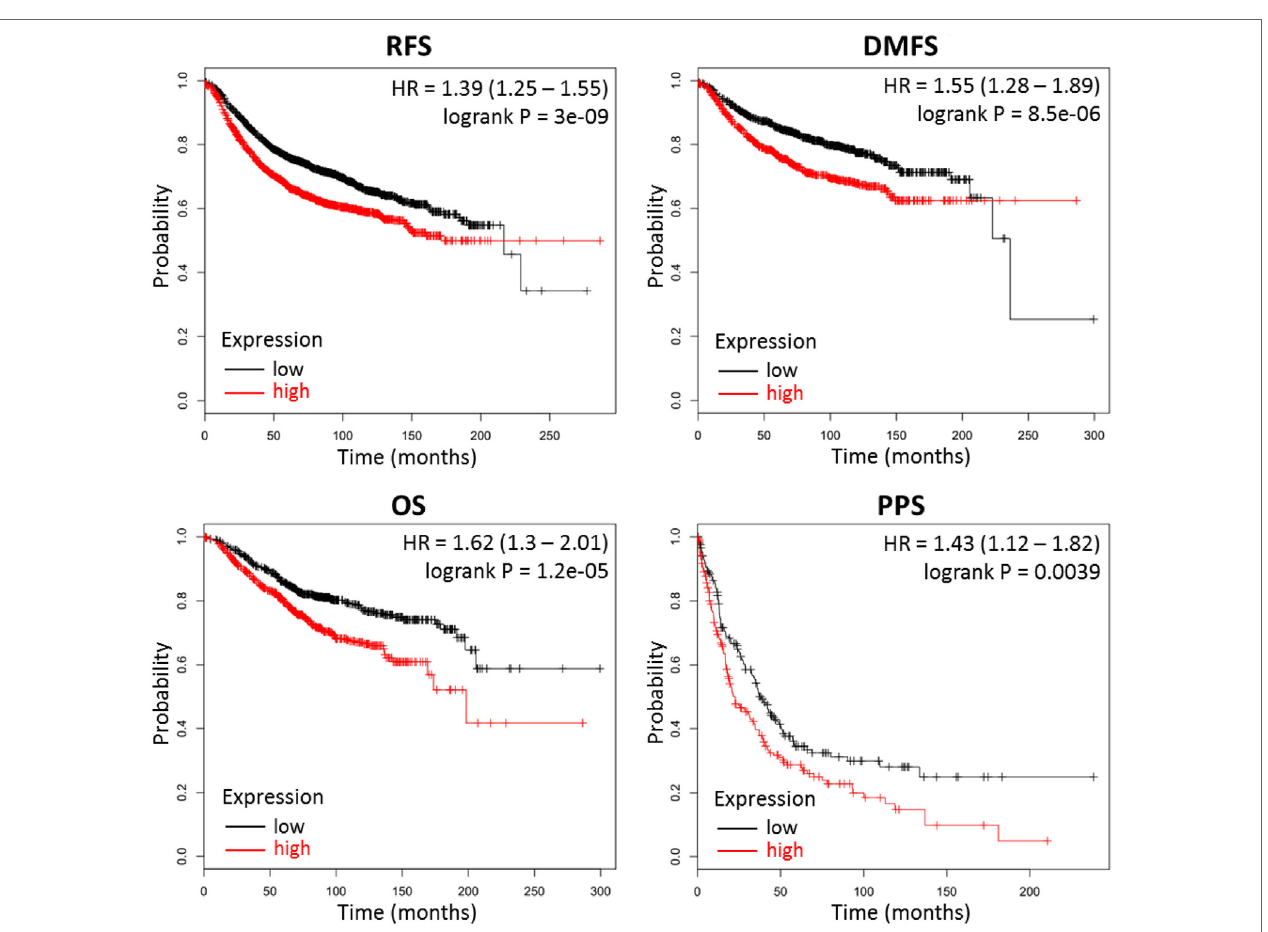
FigUre 6 | Combined GNE and CMAS expression is strongly associated with decreased survival in breast cancer patients. Kaplan–Meier survival curves were generated by KM Plotter (47) using transcription data and patient survival information extracted from Gene Expression Omnibus (GEO) datasets. Abbreviations: RFS, relapse-free survival; DMFS, distant metastasis-free survival; OS, overall survival; PPS, postprogression survival. Overall expression of GNE and CMAS is represented by the mean of individual gene expression values. The median expression value was used as the cut-off value for determining high- versus low- expression patient groups.